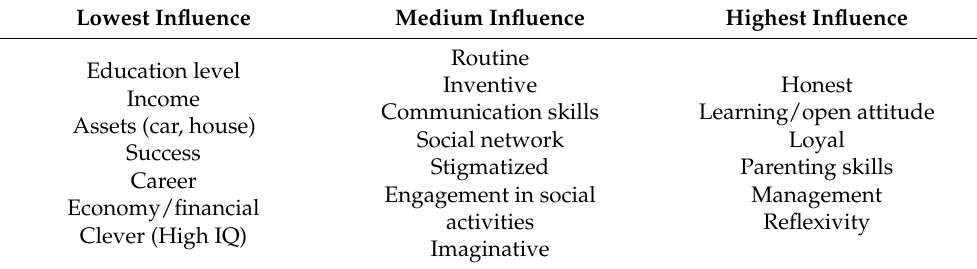
Table 4. Classification made by the respondents on what they consider most influential in recognizing resourceful